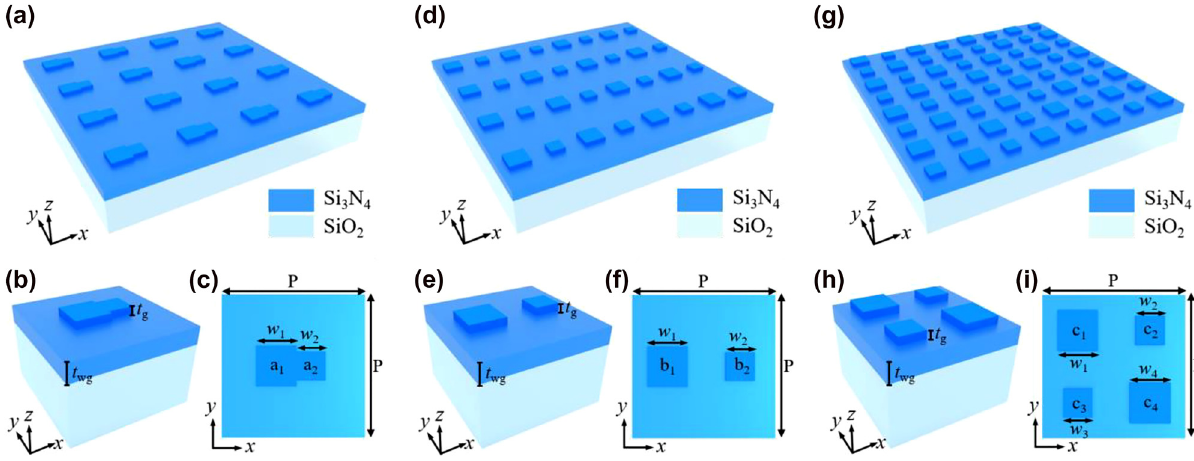
Figure 1: Structure of the asymmetric metasurfaces. (a) Schematic of the Si views of a unit cell of the monomer metasurface. (d–f) Schematic of the Si